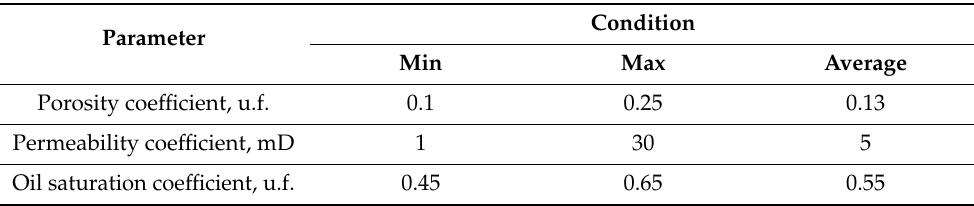
Figure 4. Location of considered hydrocarbon (HC) reservoirs on a map of Russian Federation and lithography description of one of them. lithography description of one of them. Table 1. Example of rules for initial data Table 1. Example of rules for initial data validation.